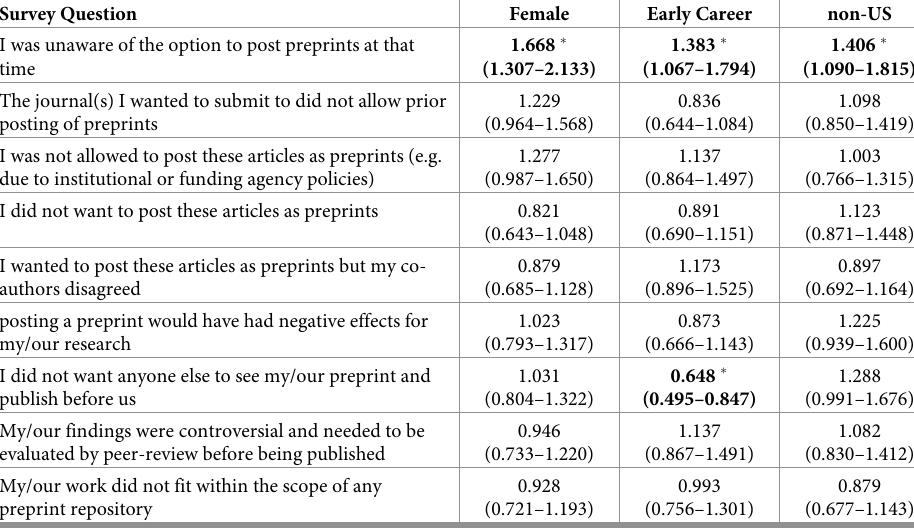
Table 5. Results of ordinal logistic regression for survey questions in Fig 7 (corresponding authorships only; N = 1021). Values are presented as exponentiated odds-ratios, with the range in parentheses representing 95% confi- dence intervals. Significant results at the 95% level are indicated in bold and with “ �